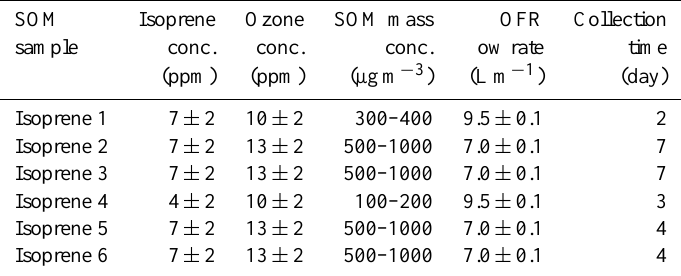
Table 1. Experimental conditions for production of isoprene-derived SOM particles using the oxidation flow reactor. Particles were deposited on substrates using an electrostatic precipitator. SOMs from isoprene samples 1, 2, and 3 were collected on Teflon substrates for the bead- mobility experiments, and SOMs from isoprene samples 4, 5, and 6 were collected on salinized substrates for the poke-flow experiments. SOM Isoprene Ozone SOM mass OFR sample conc.